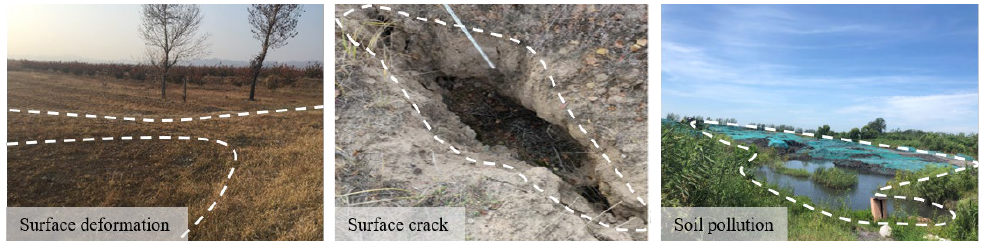
Figure 11. Damage to ecological environment.